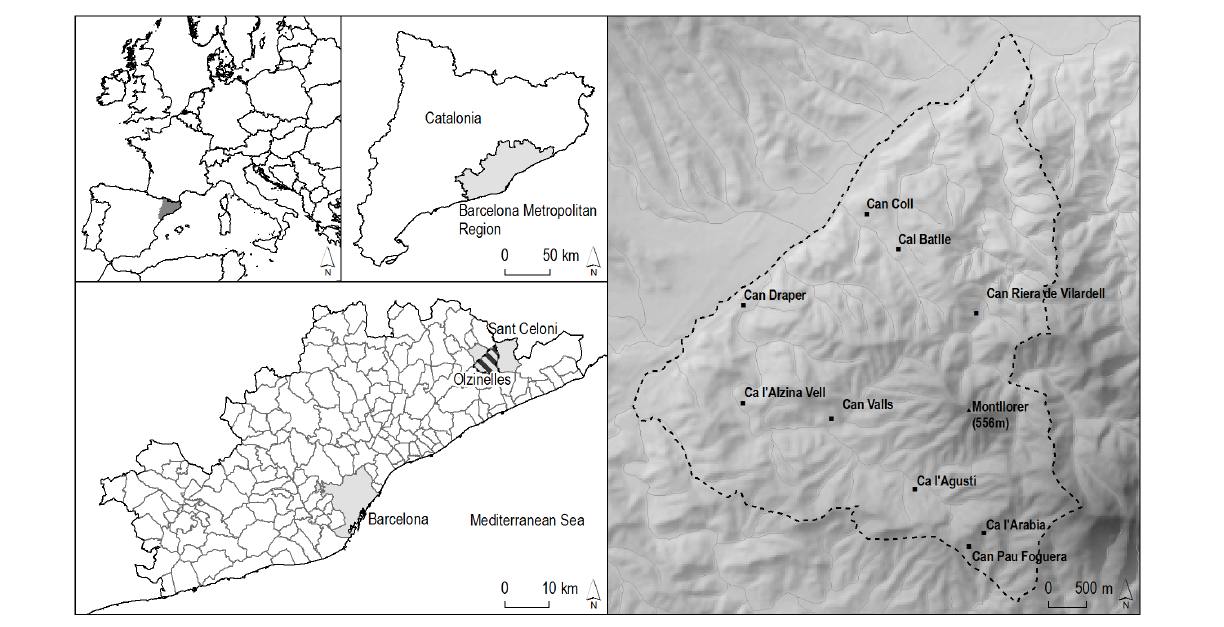
Fig. 1 . Study area within Europe, Catalonia, and the Barcelona Metropolitan Region. Source: Reprinted from Otero et al. (2013) with permission from